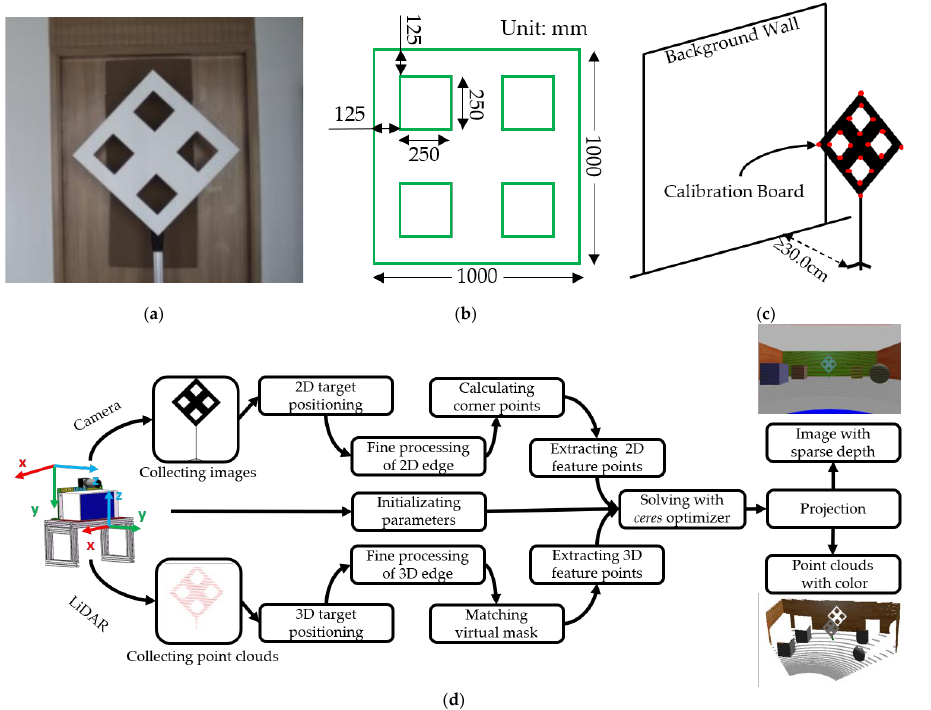
Figure 2. Calibration board and flow chart of proposed method, ( a ) is the calibration board, ( b ) is the geometric dimension drawing (unit: mm), ( c ) is the location of calibration board, red points represent the feature points we need, and ( d ) is the diagrammatic sketch. Table 1. Symbols and functions definitions.